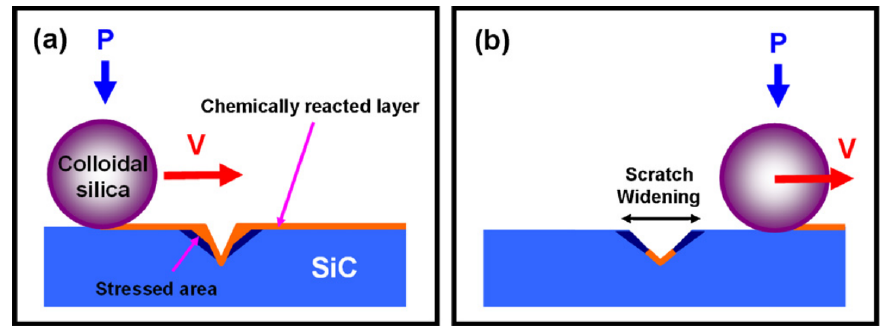
Figure 5. ( a ) The MRR of a 6H – SiC surface polished with a colloidal silica slurry and MAS; the AFM images and roughness values of a 6H – SiC surface polished with ( b ) a colloidal silica slurry and ( c ) MAS (diamond concentration: 25 g/L) [25].